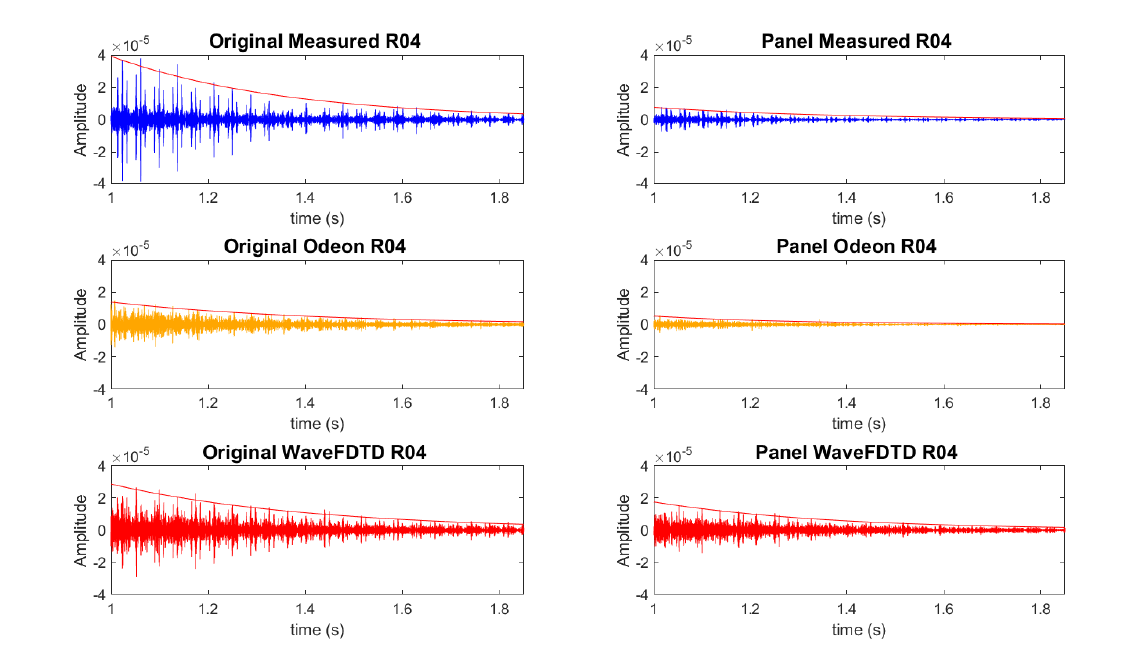
Figure 14. MRA of measured and modeled RIR at R04 located on the aisle 3m from source. Comparison of the original room and the room with the addition of the acoustical panels. Red lines represent exponential decay of peaks and are included to aid in visualization of the signal